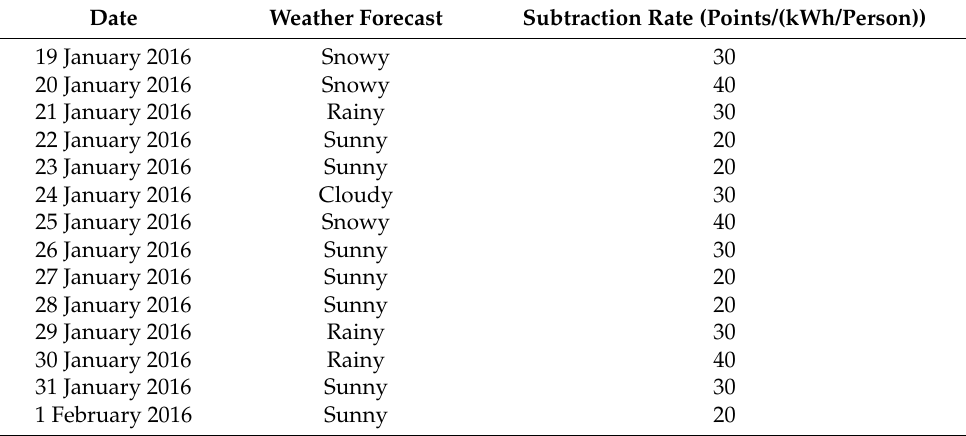
Table 4. Daily weather forecast in